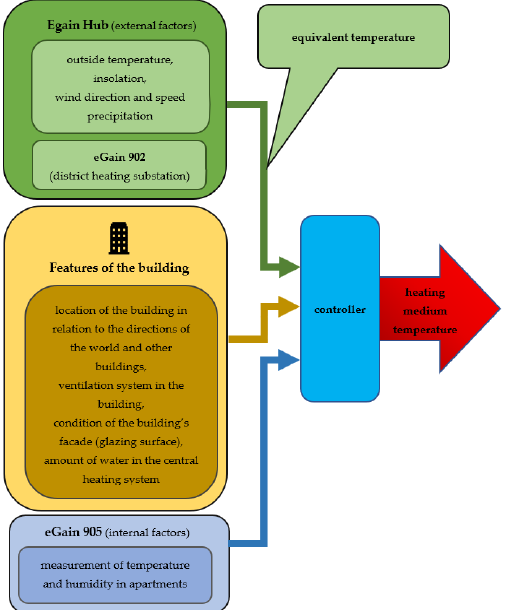
Figure 3. Compilation and comparison of elements included in heating regulation systems [own study].